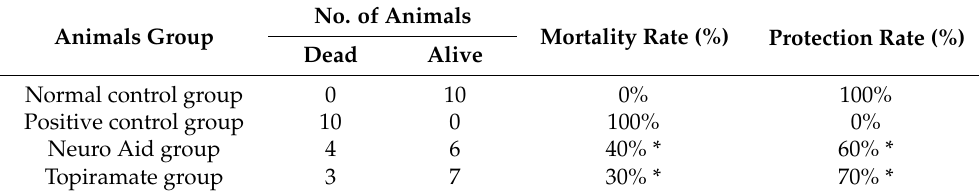
Table 2. Effects of NeuroAid and topiramate on the mortality rate and protection of mice. Animals Group